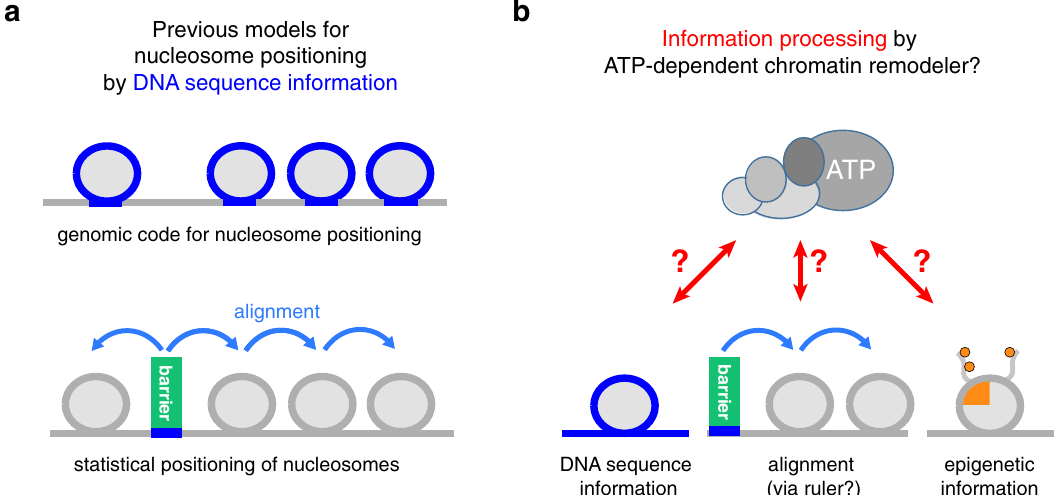
Fig. 1 Models for nucleosome positioning mechanisms. a Genomic code for nucleosome positioning 14,15 and statistical positioning 16 are two previous models, which exemplify a direct versus indirect role, respectively, of DNA sequence information (blue) for determining nucleosome positioning. b In light of the decisive role of ATP-dependent chromatin remodelers in nucleosome positioning 24,28,29,86 , we asked if and how these large, macromolecular machines actively process (epi)genetic information together with their own remodeler-speci fi c information into stable nucleosome